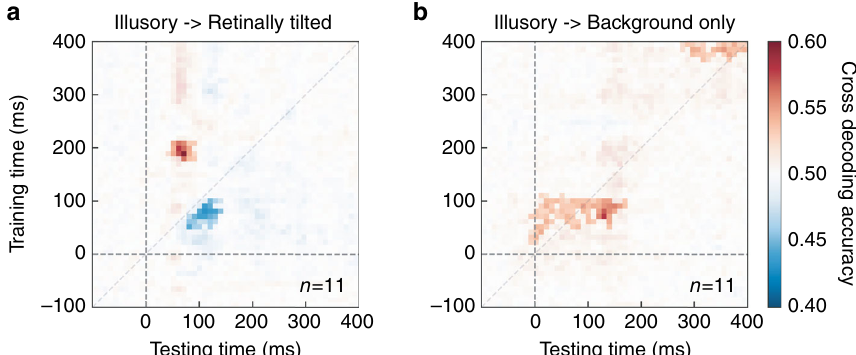
Fig. 5 Cross-decoding analysis results. The color in each cell of the matrix indicates decoding accuracy if the classi fi er was trained with data from one time in one condition, and tested with data from another time in another condition. a Trained with illusory and tested with retinally tilted condition. b Trained with illusory and tested with background. The highlighted cells were signi fi cantly different ( p threshold = 0.05) from chance level (50%) according to cluster-based permutation test, corrected for multiple comparisons. Source data are provided as a Source Data fi le.